Question: Looking at the figure, what chart type is it?
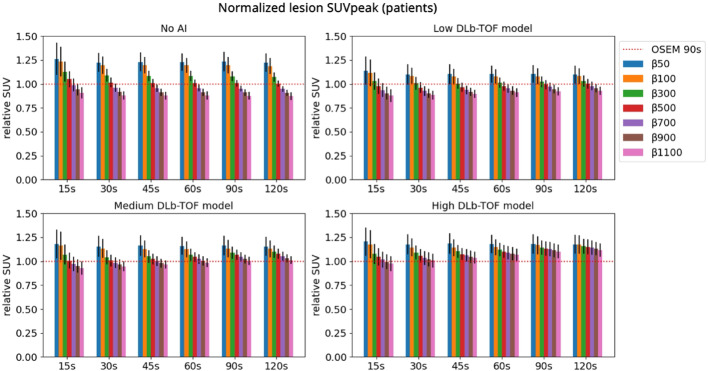
Answer: bar